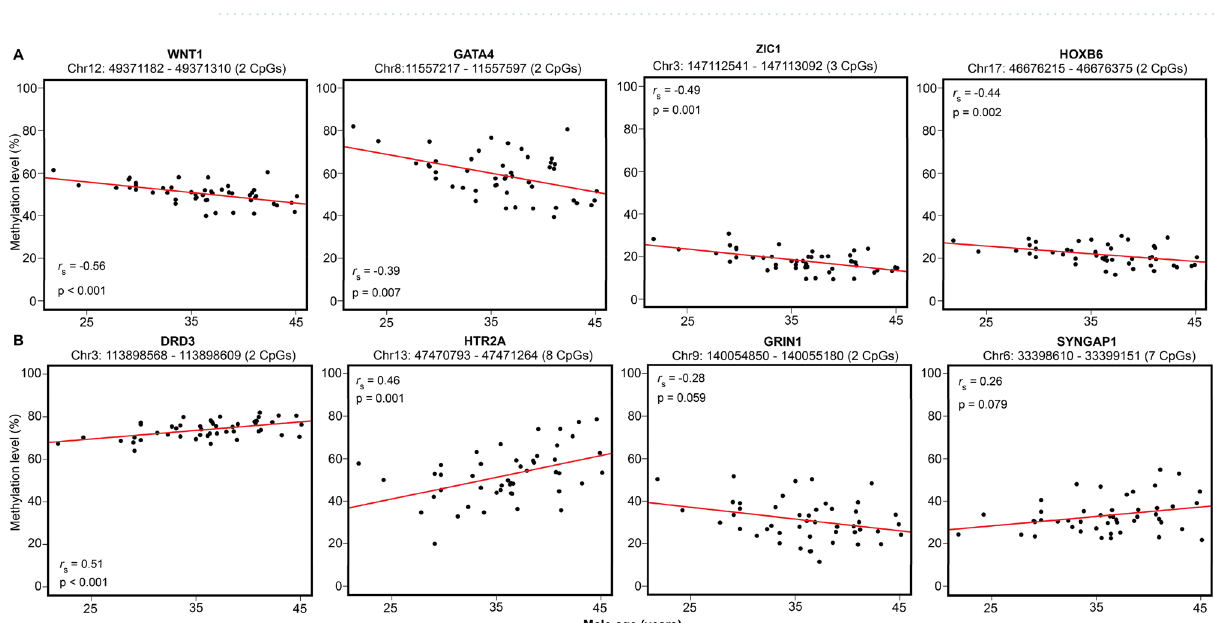
Figure 5. Scatterplots of age-related sperm DNA methylation. Selected genes associated with ( A ) early embryonic development ( B ) behavioral patterns. Genomic locations based on GRCh37/hg19 2009 human